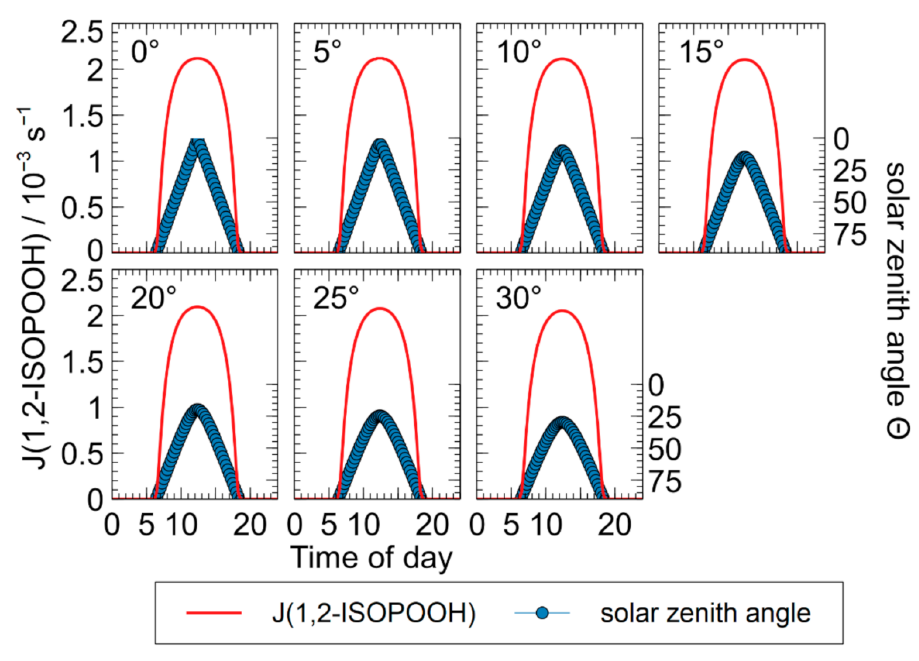
Figure 4. Photolysis rate of 1,2-ISOPOOH over the course of a day on 21 March at latitudes between 0 ◦ and 30 ◦ .